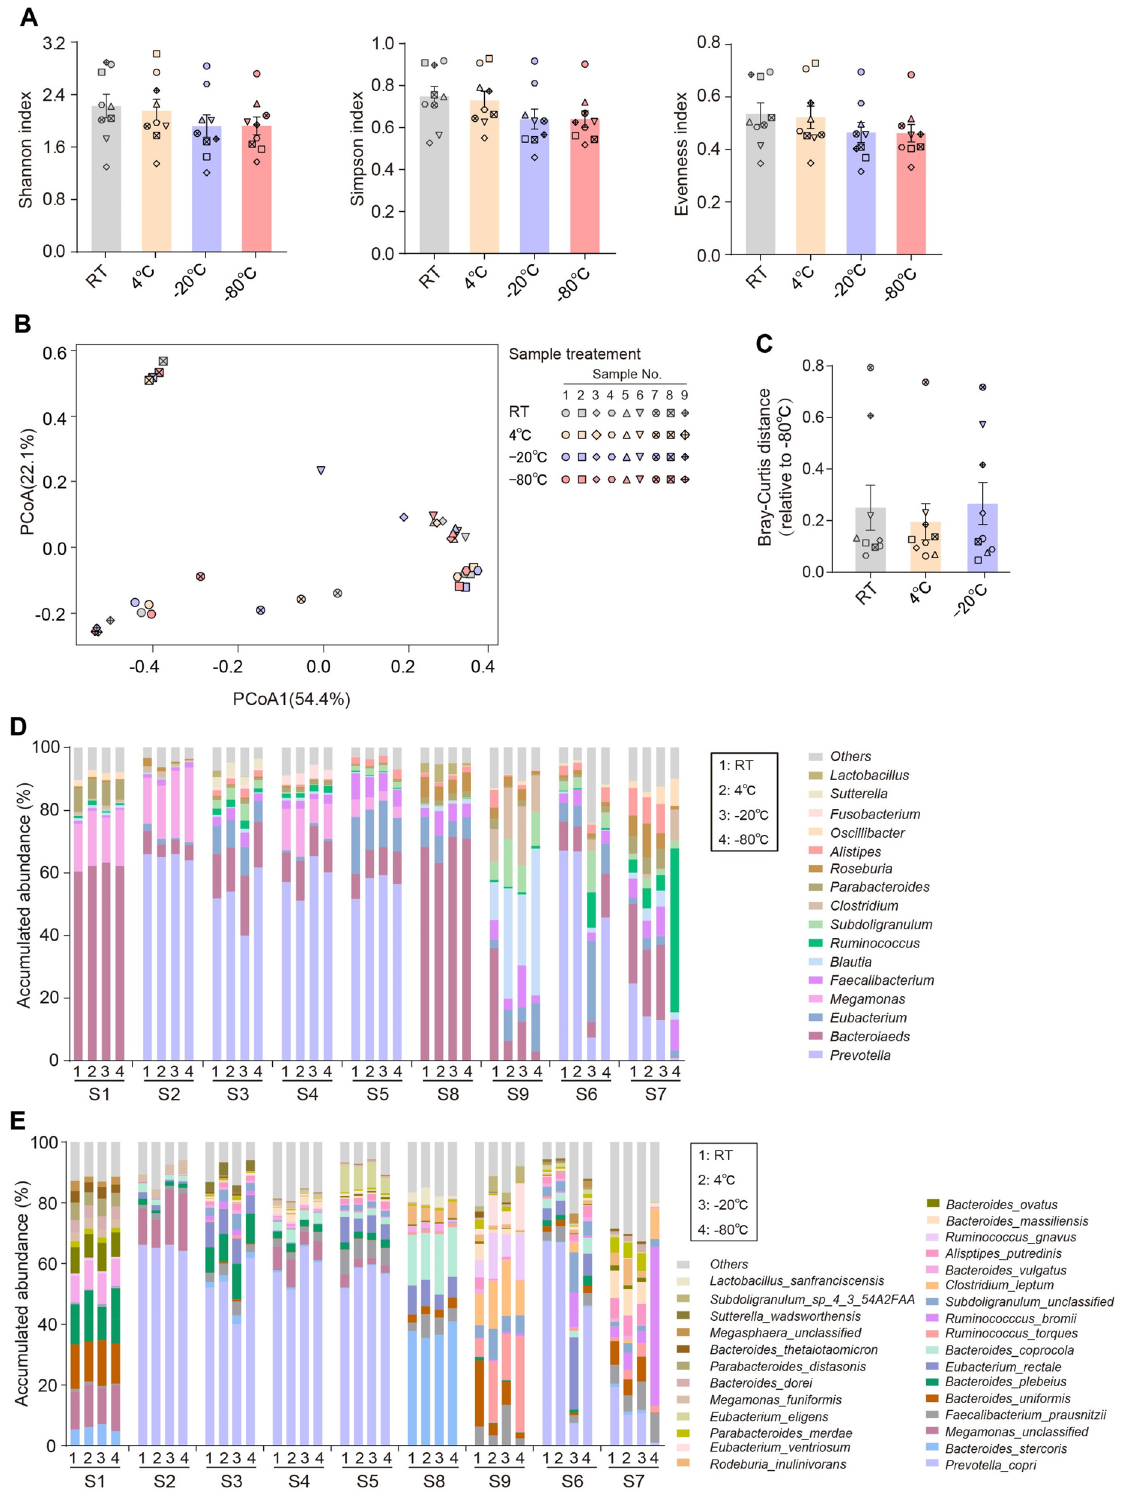
Figure 1. Stability analysis of human fecal microbiota at different storage temperatures within 4 h. ( A ) Shannon, Simpson and Evenness indices of microbial structure in fecal samples under room temperature (RT), 4 °C, − 20 °C and − 80 °C, respectively. ( B ) Principal Coordinate Analysis (PCoA) plots of microbial communities. ( C ) Bray–Curtis distance of microbiome in fecal samples to that in − 80 °C-frozen samples. The relative abundance pattern at the genera ( D ) and species ( E ) level of samples under each indicated condition. N = 9 volunteers/group, each point shape in ( A – C ) represents an